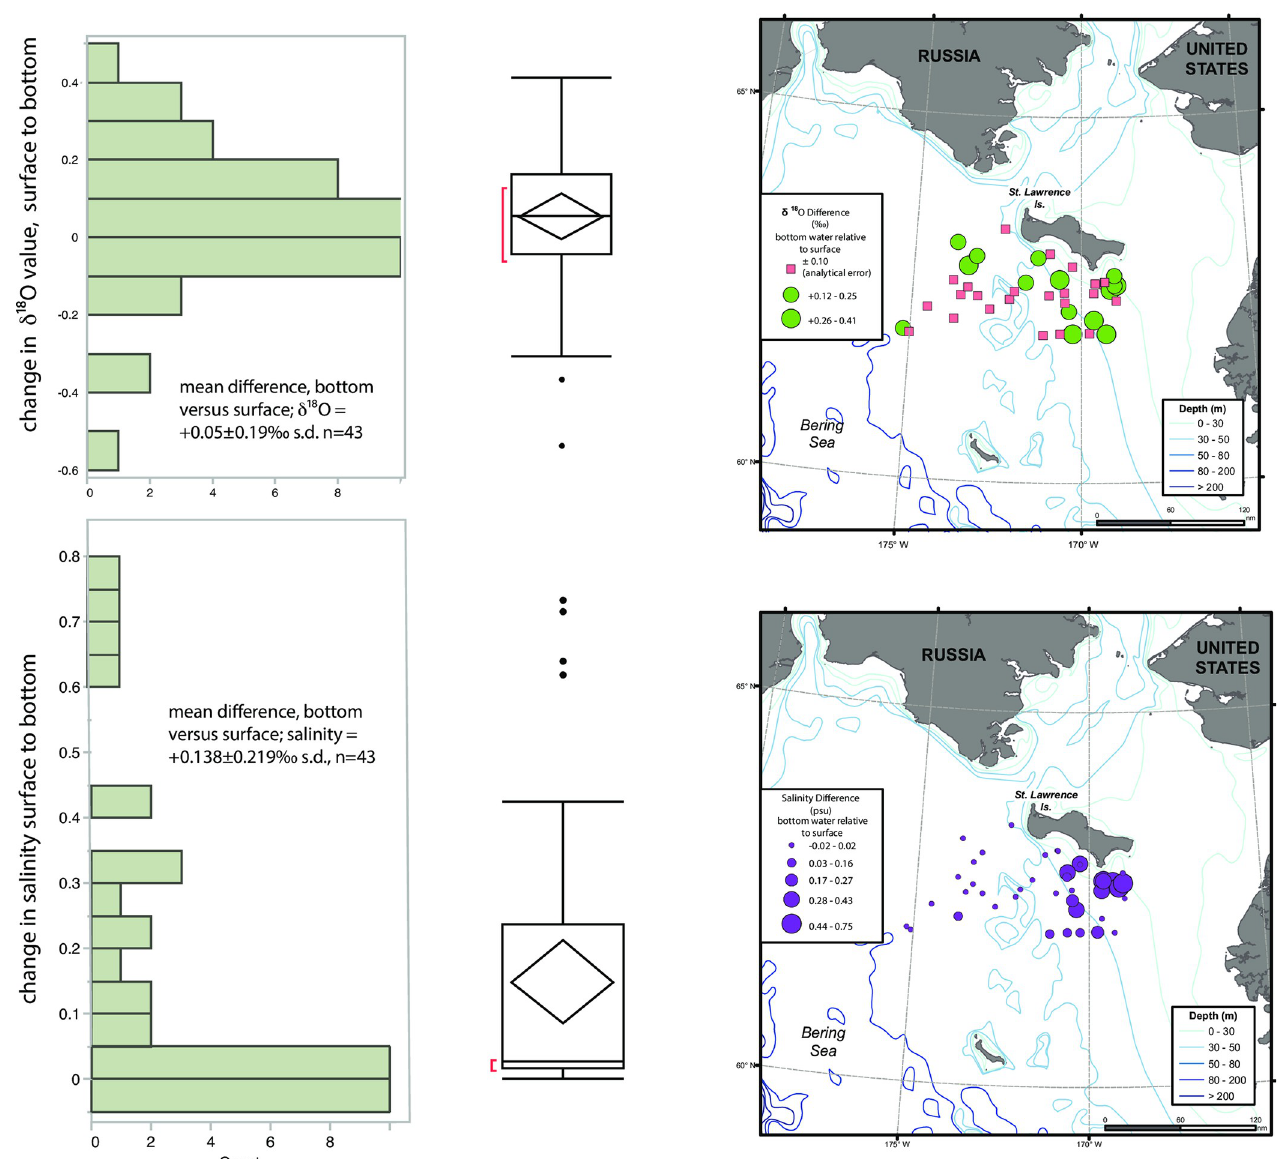
Fig 2. Difference in δ 18 O values (top) and salinity (bottom) between surface waters and bottom (~50 m) in an active area of sea ice formation, St. Lawrence Island polynya, March 2009. Outlier box plot shows 95% confidence limits, n = 43. The figure was made in part with ArcGIS 10.3 under a CC BY license, with permission from ESRI